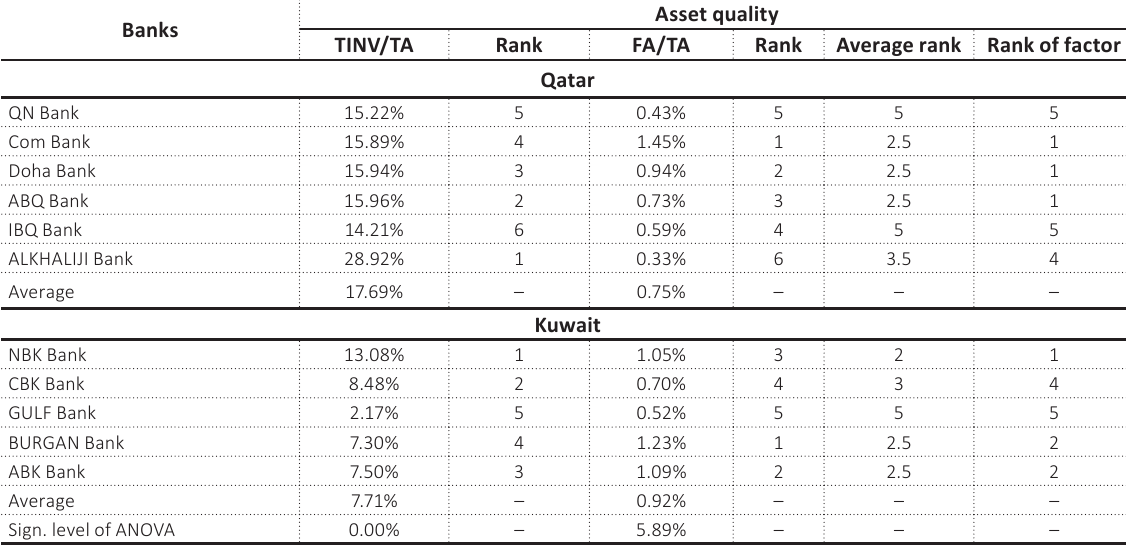
Table 4. Average ratios of years and rankings in the case of the Asset quality factor at selected